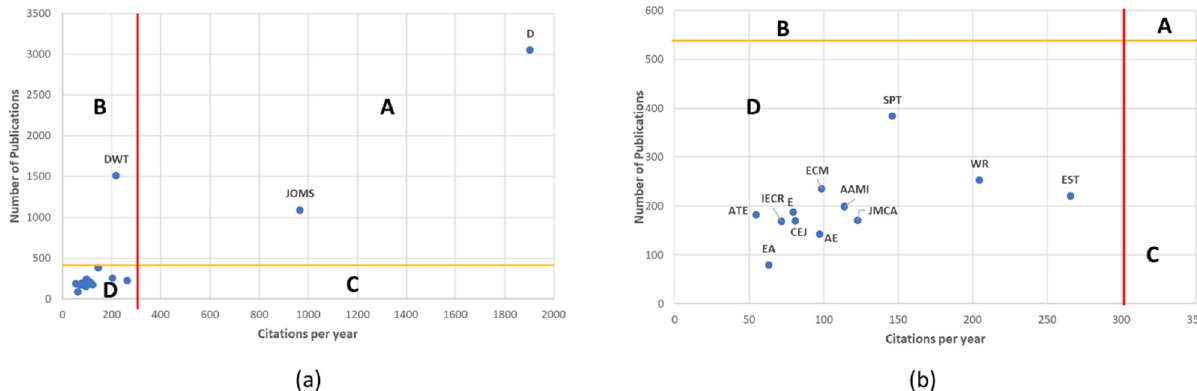
Figure 8: Classi fi cation of the top 15 contributing journals on desalination: ( a ) full view, ( b ) zoom - in view. EST: Environmental Science